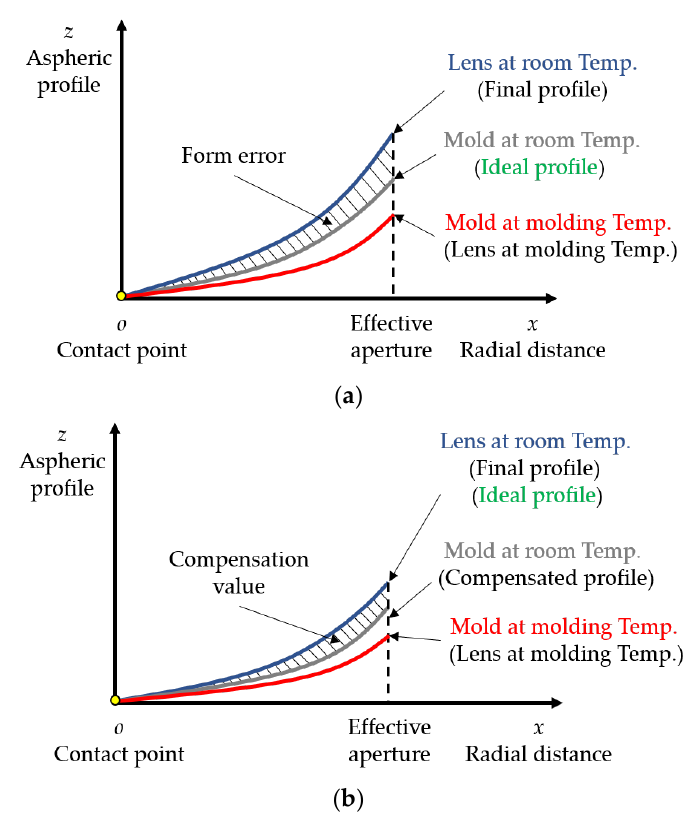
Figure 4. Schematic diagram of the mold and lens surface profiles change in the PGM process. ( a ) Uncompensated mold and ( b ) compensated mold.